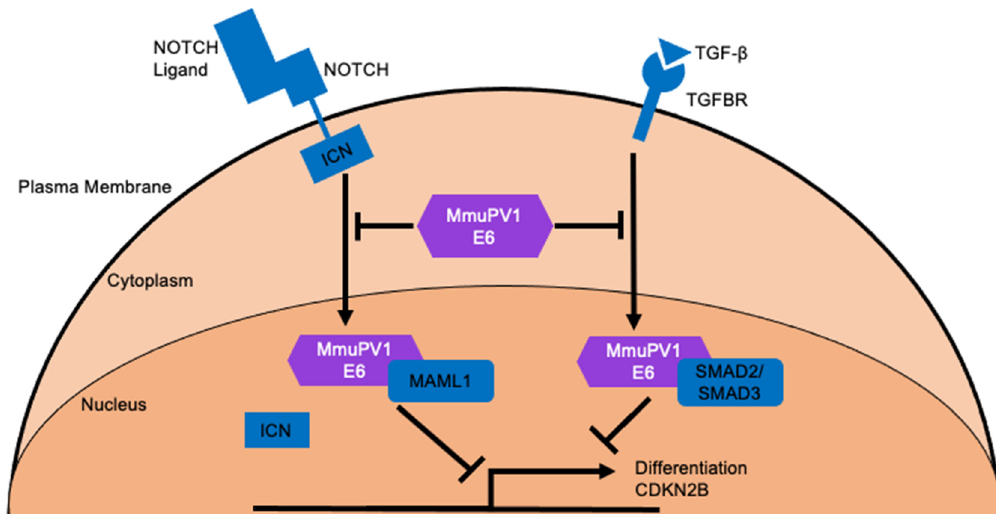
Figure 3. MmuPV1 E6 cellular targets and the outcomes of these interactions. MmuPV1 E6 has been shown to interact with MAML1 and SMAD2/SMAD3 which are critical co-activators of NOTCH and TGF- β signaling, respectively [98]. MmuPV1 E6 binds to these important transcriptional activators and prevents their ability to promote transcriptional activation of NOTCH and TGF- β responsive genes following stimulation with appropriate ligand. One important biological outcome of these interactions is the inhibition of keratinocyte differentiation [98].